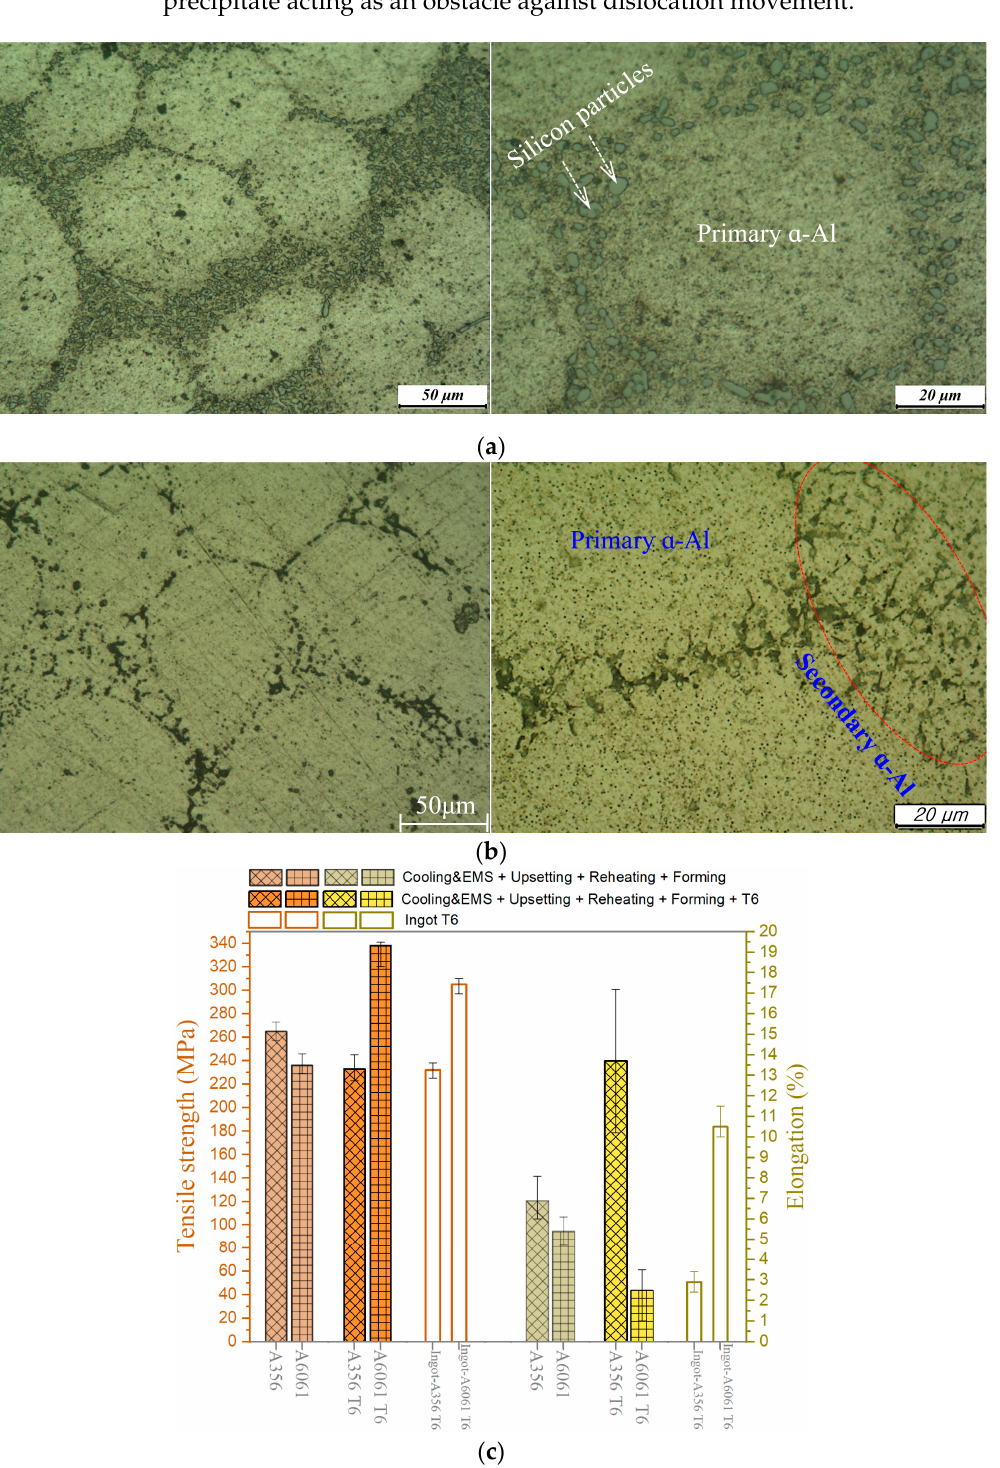
Figure 10. Comparison of characteristic between before T6 and after T6: ( a ) A356 Microstructures; ( b ) A6061 Microstructures; ( c ) Tensile strength and elongation.